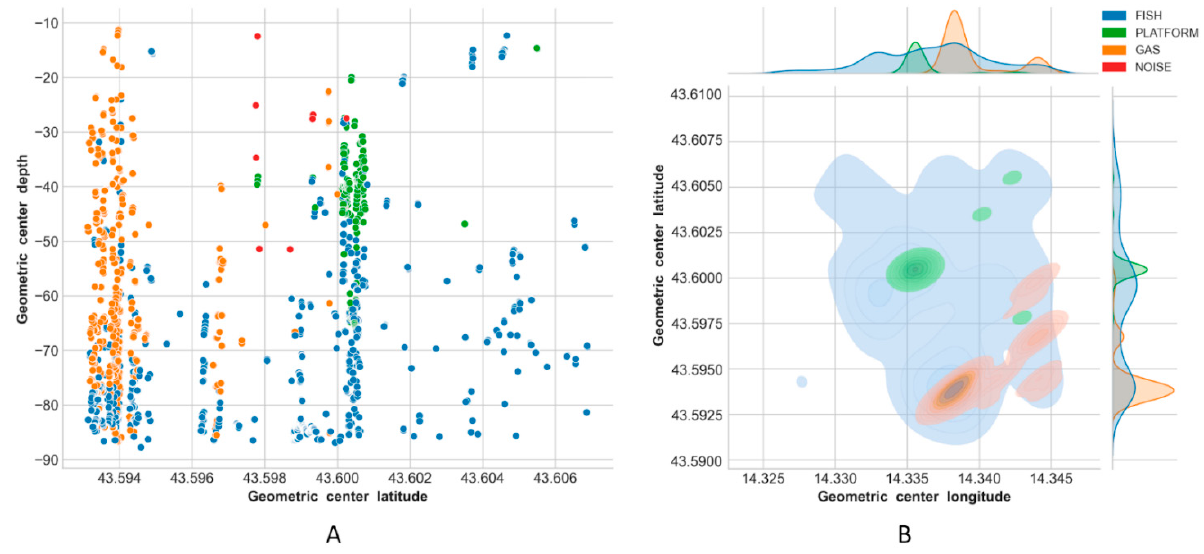
Figure 13. Predictions on Survey 1: latitude-depth view ( A ), and Kernel Density Estimation plot (top view) ( B ).